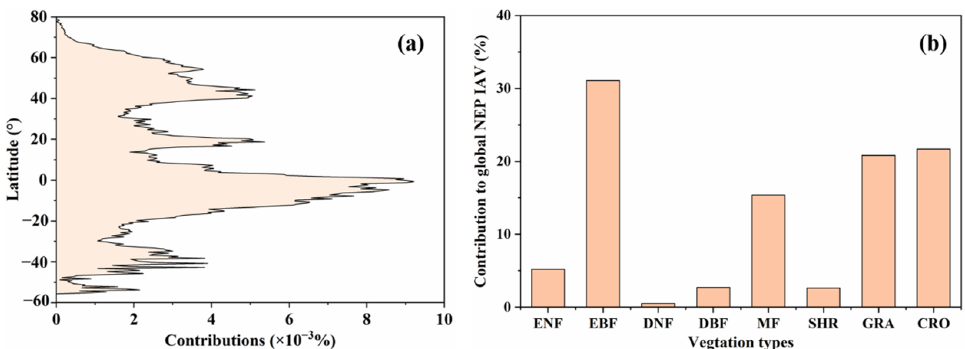
Figure 6. Contribution to global NEP IAV counted by ( a ) latitudes and ( b ) different vegetation types. Positive latitudes represent the Northern Hemisphere and negative latitudes represent the Southern Hemisphere.